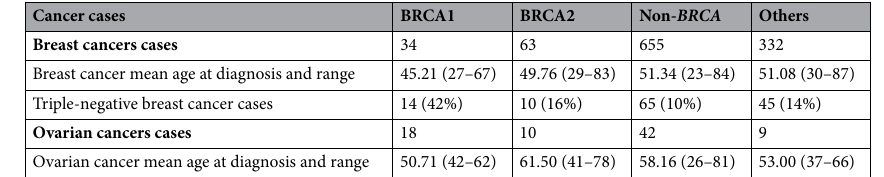
Table 4. Histopathologic and clinical characteristics of cancer cases. Mean cancer age and sample standard deviation are shown in Fig. 1. The Finnish population data is added for reference and is based on Finnish Cancer Registry 2 .